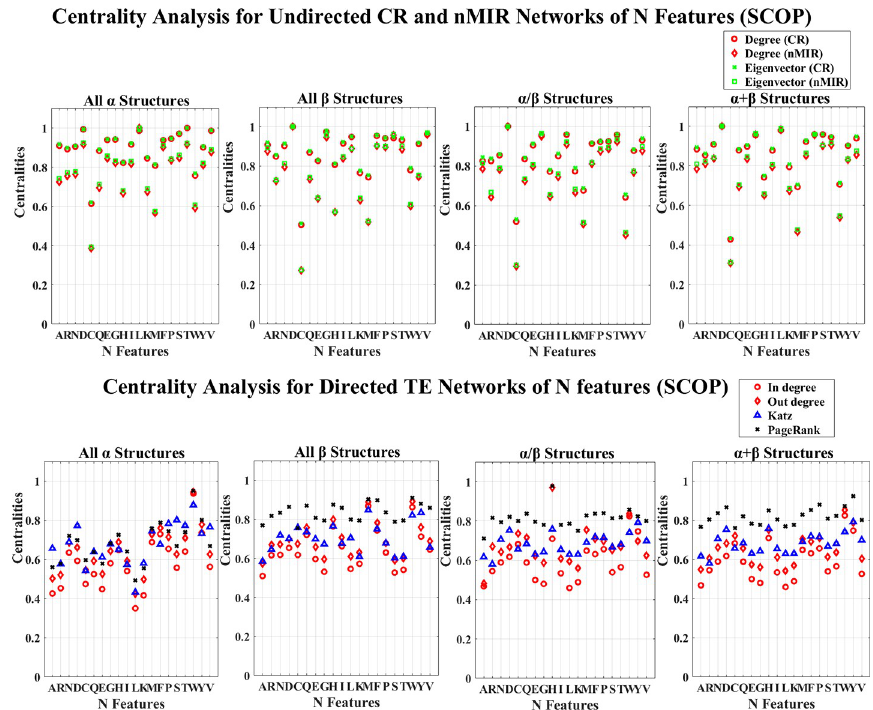
Fig 7. Centrality analysis for the networks of APF features (CATH). This figure shows the centrality results for the networks of APF features (CATH data). The normalized centralities are plotted against the features (represented by the indices of the properties as listed in S2